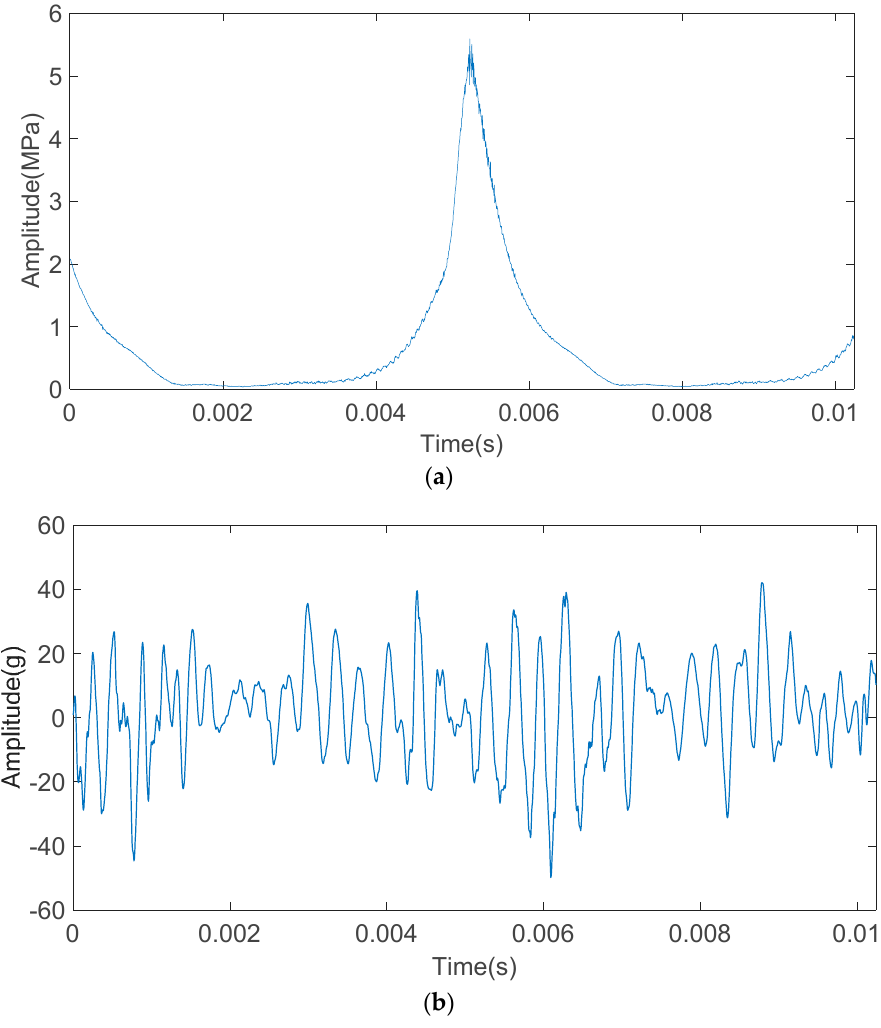
Figure 15. Time-domain waveform of the cylinder pressure signal and the engine block vibration signal under a weak knock condition at 5200 rpm. ( a ) Time-domain waveform of the cylinder pressure signal under a weak knock condition at 5200 rpm. ( b ) Time-domain waveform of the engine block vibration signal under a weak knock condition at 5200 rpm.